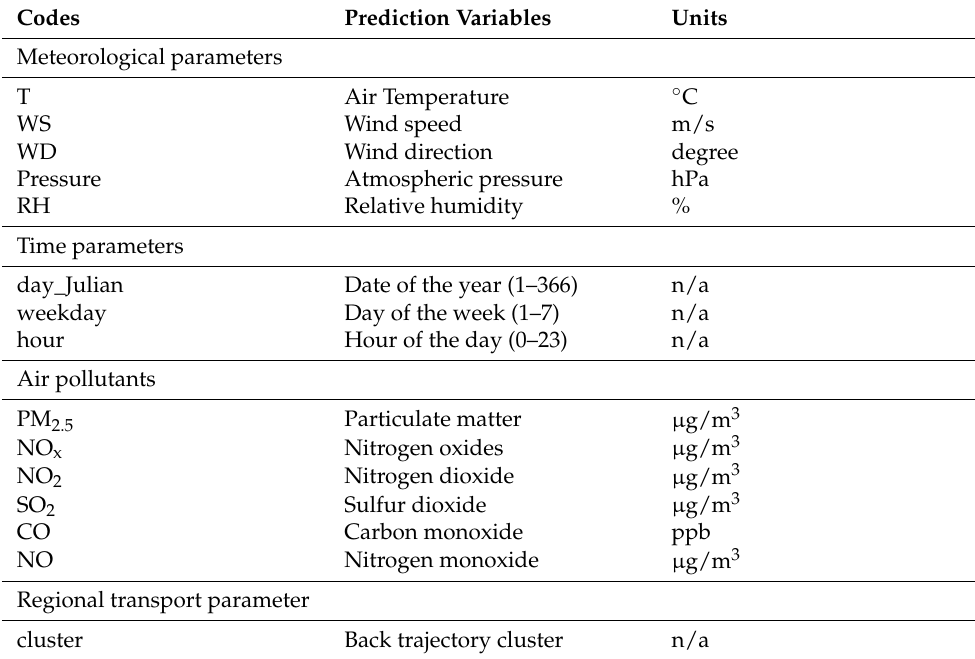
Table 1. All possible predictors for the RF models in this